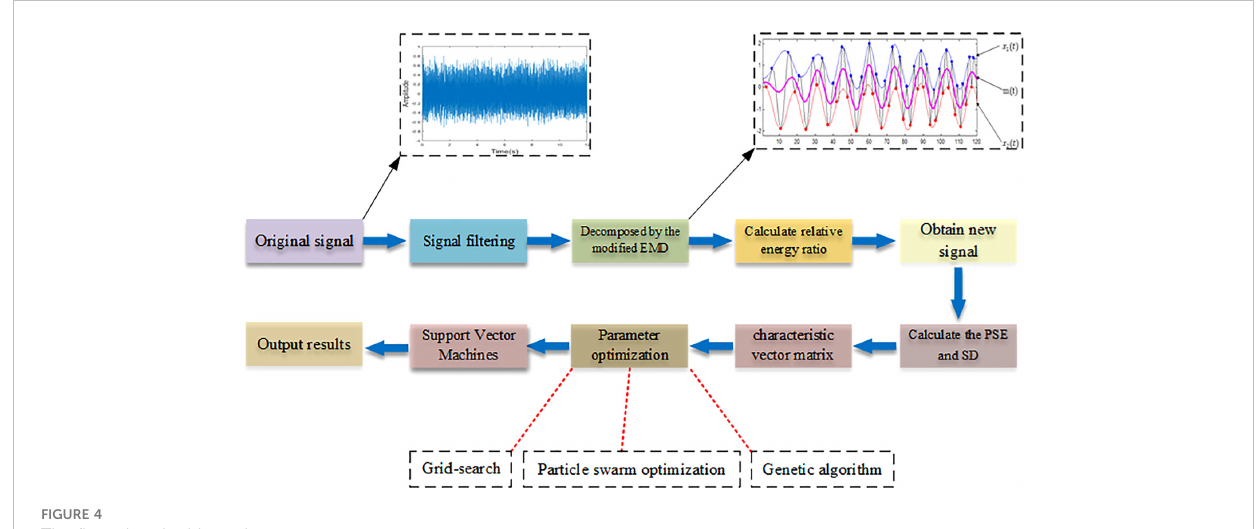
FIGURE 4 The fl ow chart in this study.